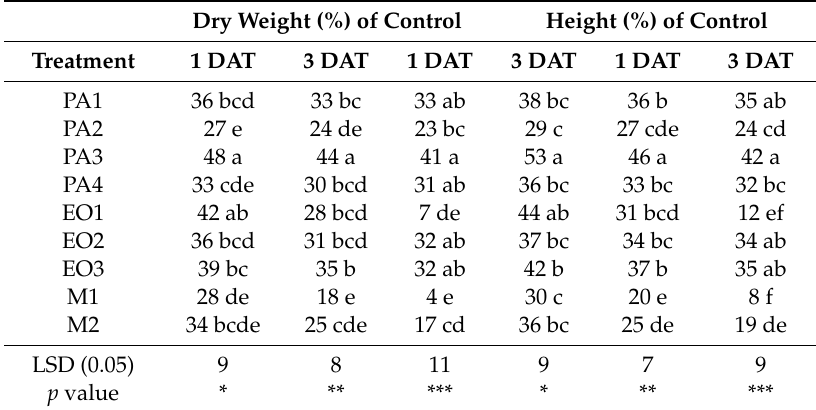
Table 4. Dry weight and height of A. sterilis plants as a ff ected by the application of the natural herbicides at 1, 3 and 7 days after treatment (DAT). Dry weight and height values of A. sterilis plants was expressed as % of control. Dry Weight (%) of Control Height (%) of Control 1